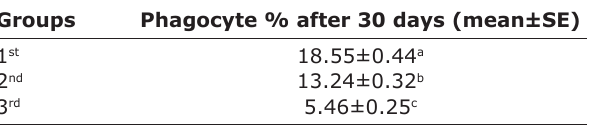
Table-4: Phagocyte assay ratio of different groups immunization at 30 days.